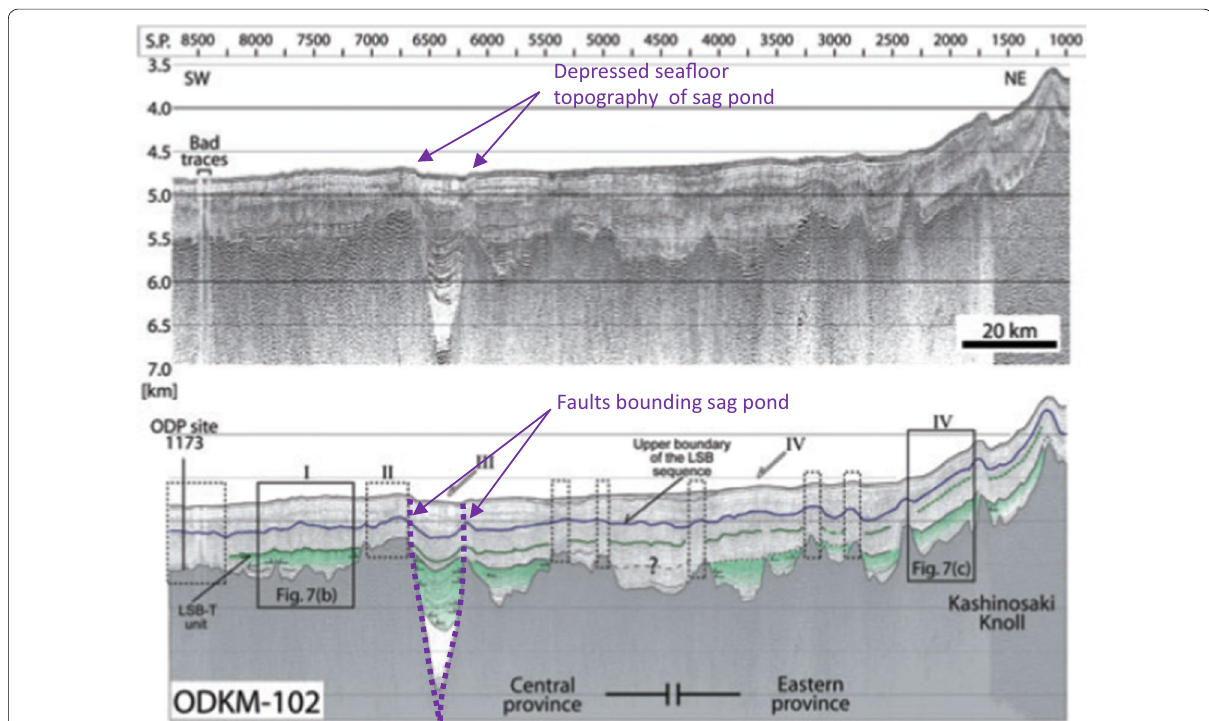
Fig. 11 Activity of faults bounding the sag pond based on Ike et al. (2008). Although present activity of the sag pond was not mentioned by Ike et al. (2008), the depressed seafloor topography implies that the faults are presently